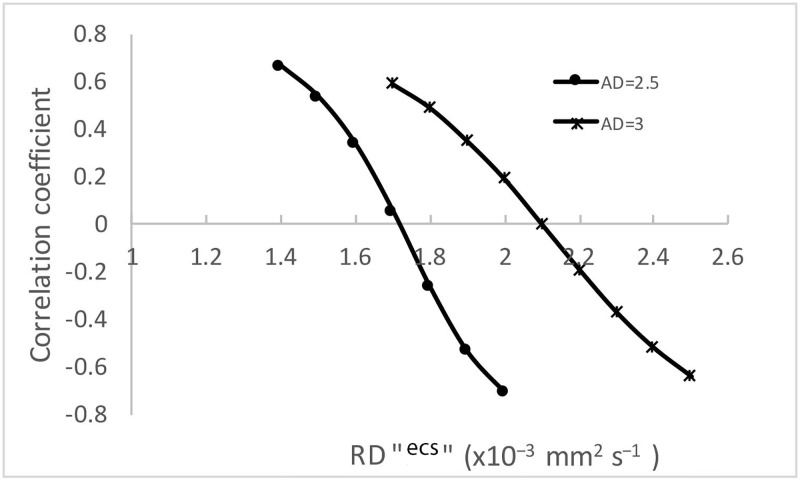
Correlation coefficients between AD and RDresidual. horizontal axe represents variation in RDECS.